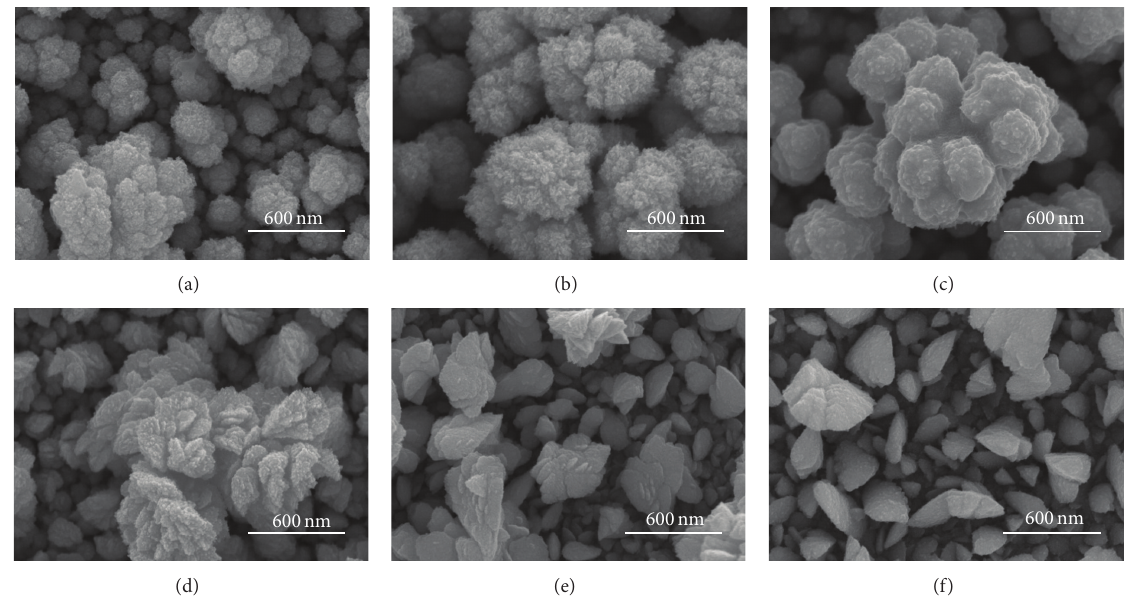
Figure 5: SEM micrographs of the electrolyte formula 0.015 M Bi(NO 3 ) 3 -5H 2 O, 0.005 M SbCl 3 , and 0.0075 M TeCl 4 ; pulse voltage was set at − 0.4 V, 𝑇 on was set at 0.2 s, and